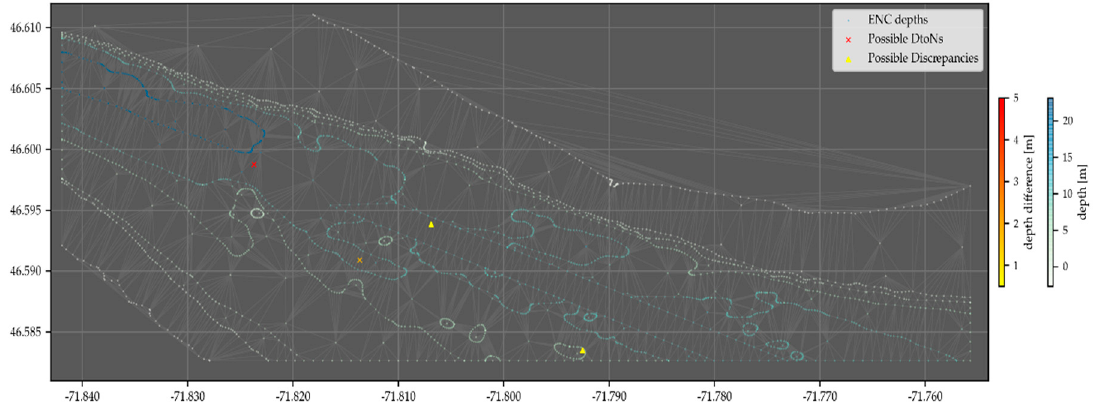
Figure 8. Algorithm results when applied to the ad-hoc input survey soundings. The possible DtoN are presented using cross markers, while triangular markers are used for the possible discrepancies. The nodes are represented as dots, with the connecting triangle edges in gray. Axes in geographical WGS84 coordinates.